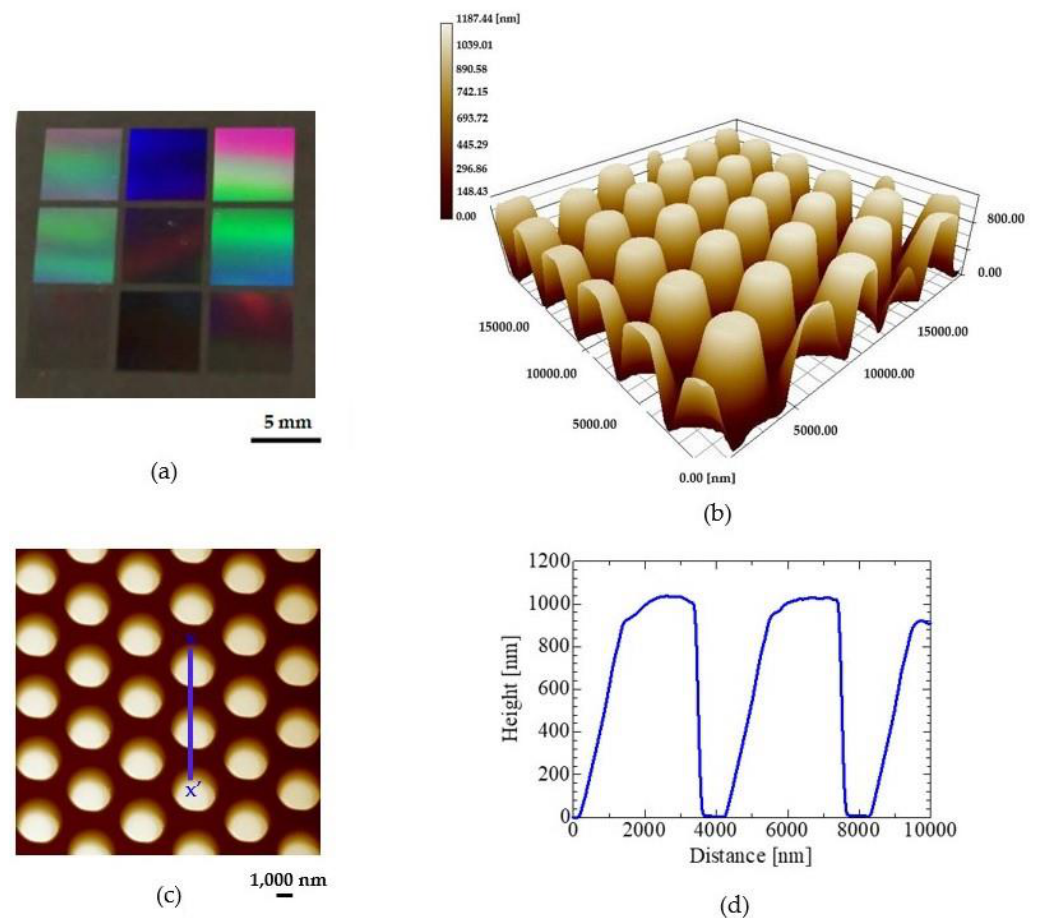
Figure 1. Silicon wafer mother mold; ( a ) the mother mold with nanostructures; ( b ) the three-dimensional image of the AFM topography image; ( c ) the top view of the AFM topography image; ( d ) the height profiles.